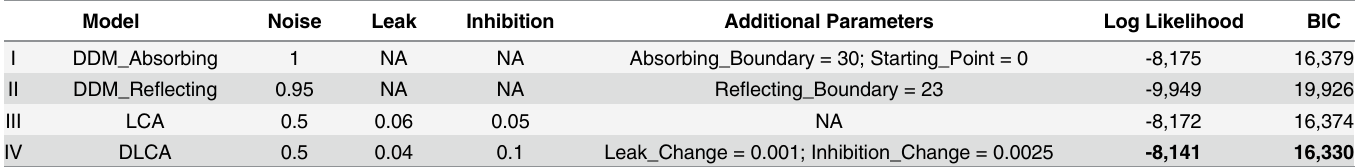
Table 1. Summary of the model comparison.